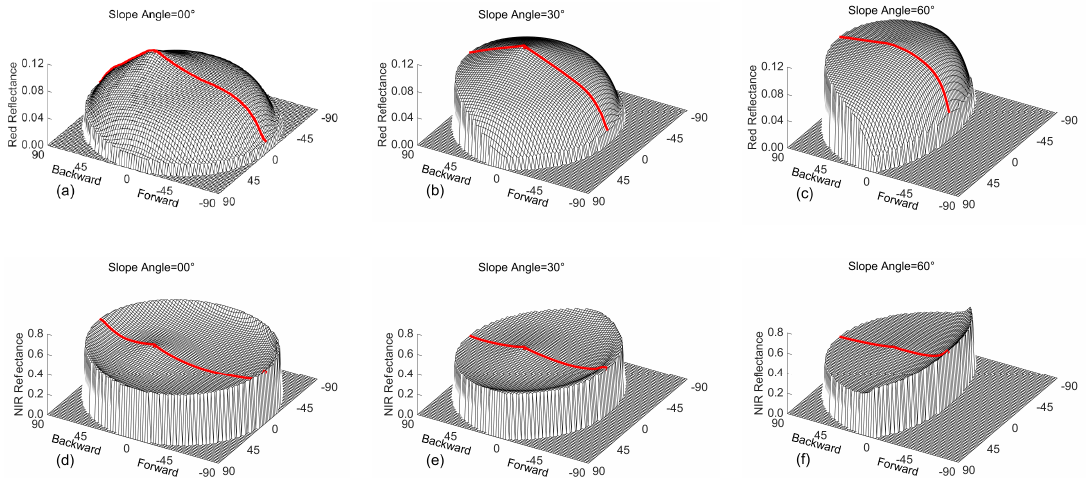
Figure 10. Solo slope reflectance simulated by the GOMST extended by the SAIL model and coupled topography (GOSAILT) model, where ( a – c ) are the red reflectance and the ( d – f ) are the NIR reflectance. The solar zenith is 30 ◦ and azimuth is 0 ◦ . The slopes aspect are also 0 ◦ ; ( a , d ) are the flat terrain; ( b , e ) are the 30 ◦ slope; and ( c , f ) are the 60 ◦ slope; Red lines indicate the BRFs along the PP. The radial distance and polar angle of polar coordinate system are view zenith angle and the view azimuth angle, respectively.